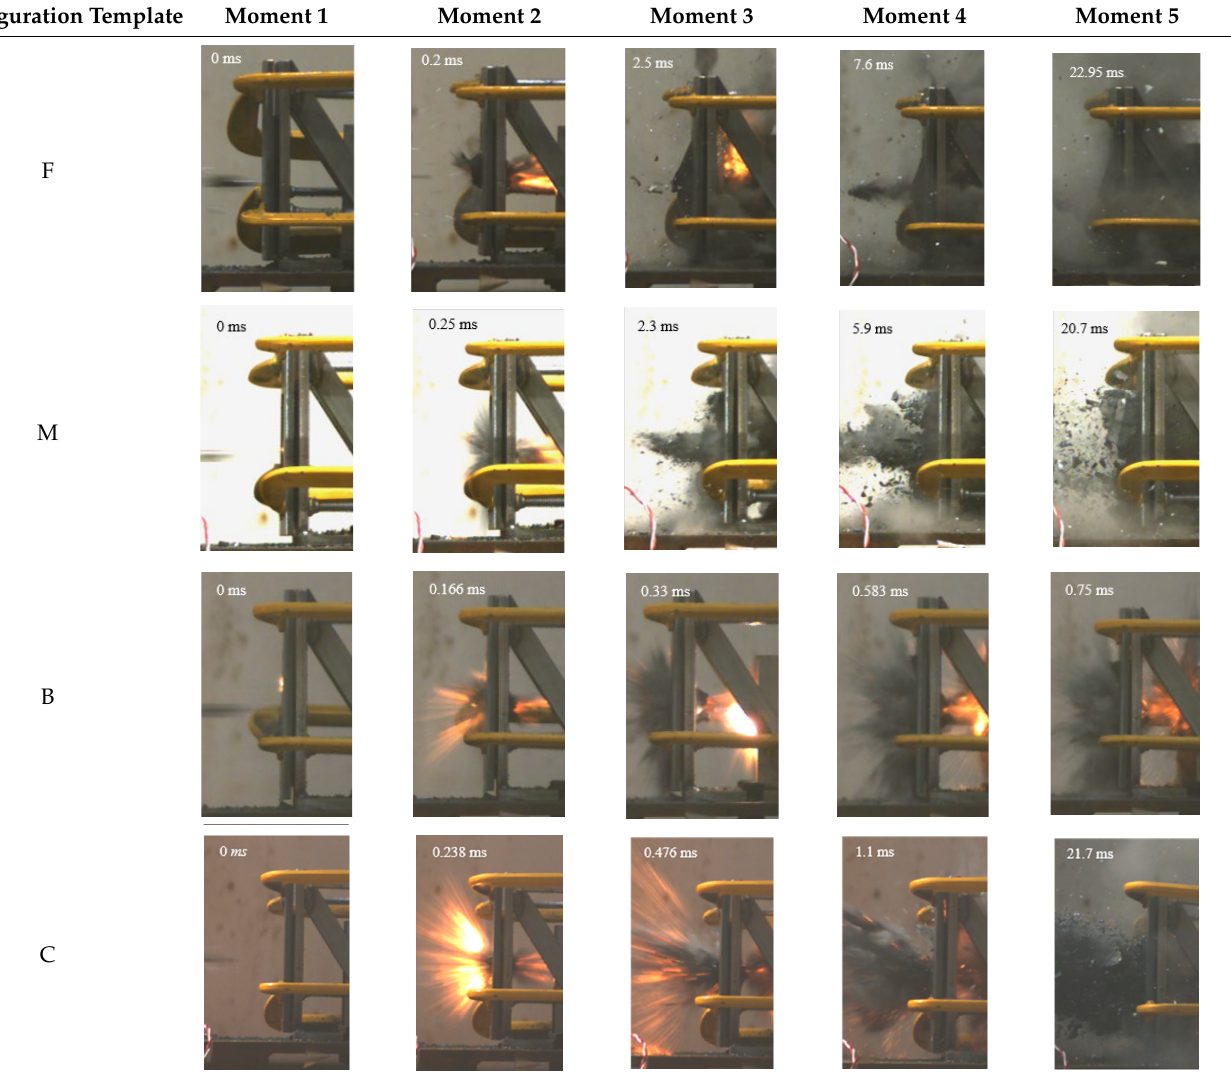
Table 4. High-speed photography of the targets.